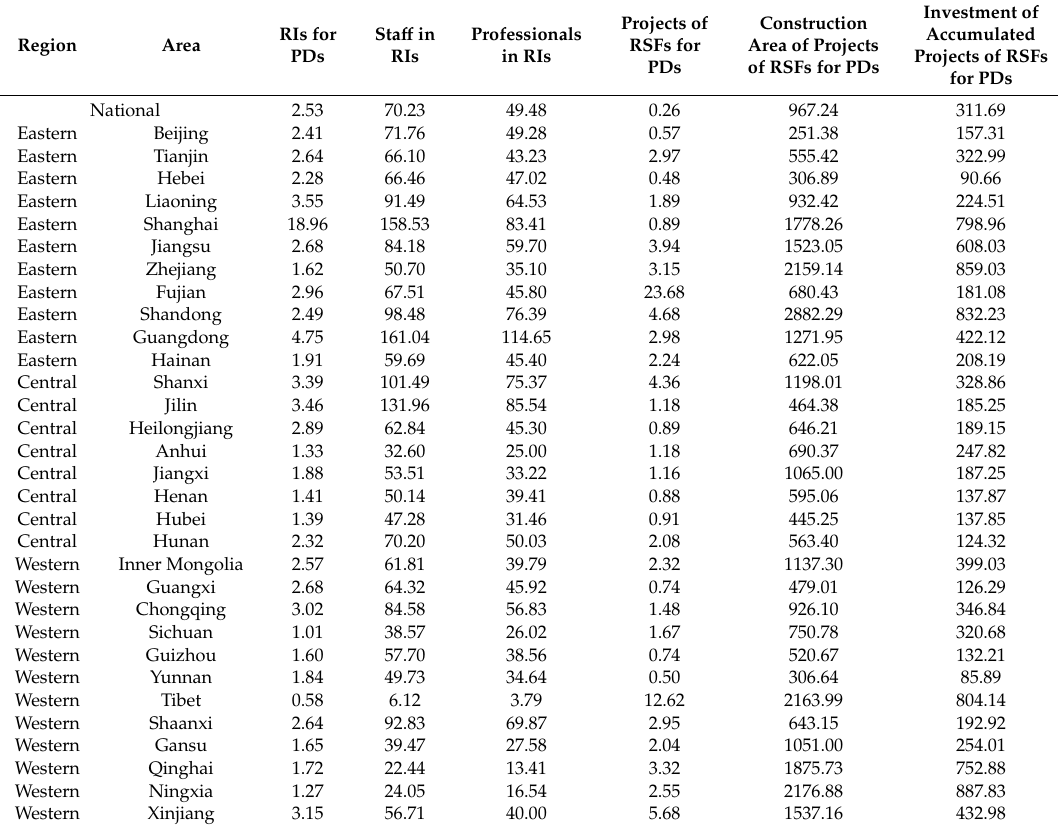
Table 2. Regional distribution per 10,000 RPDs of rehabilitation resources for PDs in China in 2018. Region Area